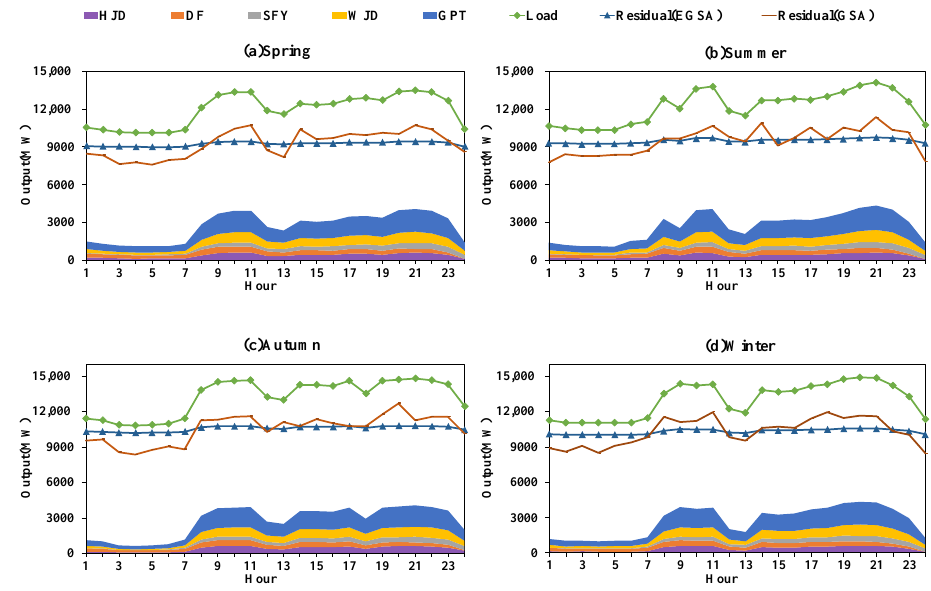
Figure 10. Detailed output process obtained by the different methods in the four cases.